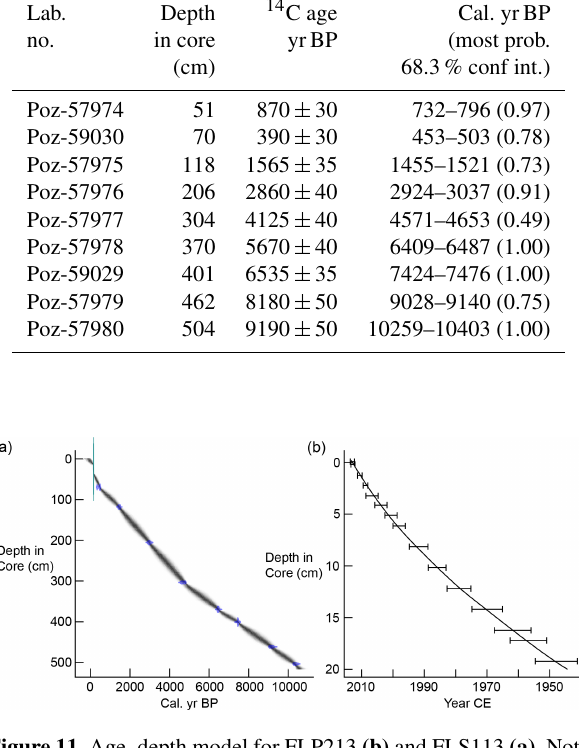
Table 5. 14 C dates for FLP213 from Flyginnsjøen. Radiocarbon ages are calibrated using the IntCal 13 calibration curve (Reimer et al., 2013). Lab.